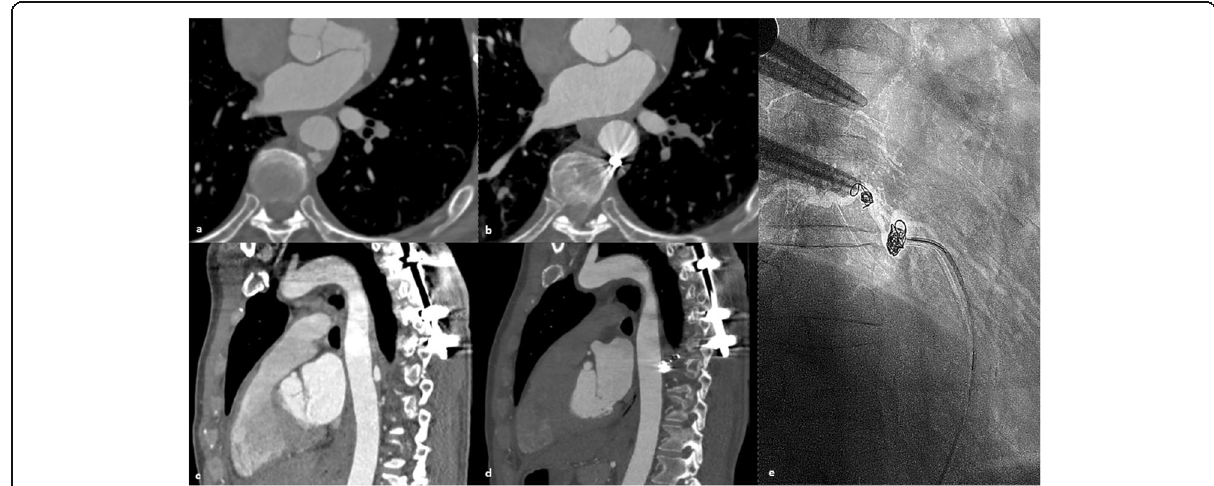
Fig. 2 a , b Thoracic aortogram in oblique position shows pre and post treatment appearance of the aortic injury (grade II-III) treated